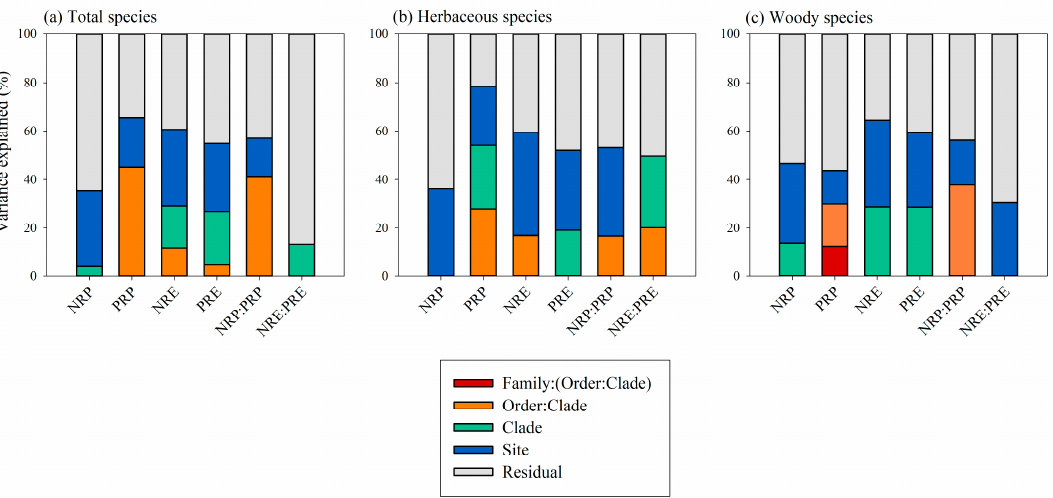
Figure 2. Variance component analysis of leaf N and P resorption traits using phylogenetic nested analysis of variance. ( a ) Variance component analysis of leaf N and P resorption traits in total species. ( b ) Variance component analysis of leaf N and P resorption traits in herbaceous species. ( c ) Variance component analysis of leaf N and P resorption traits in woody species.